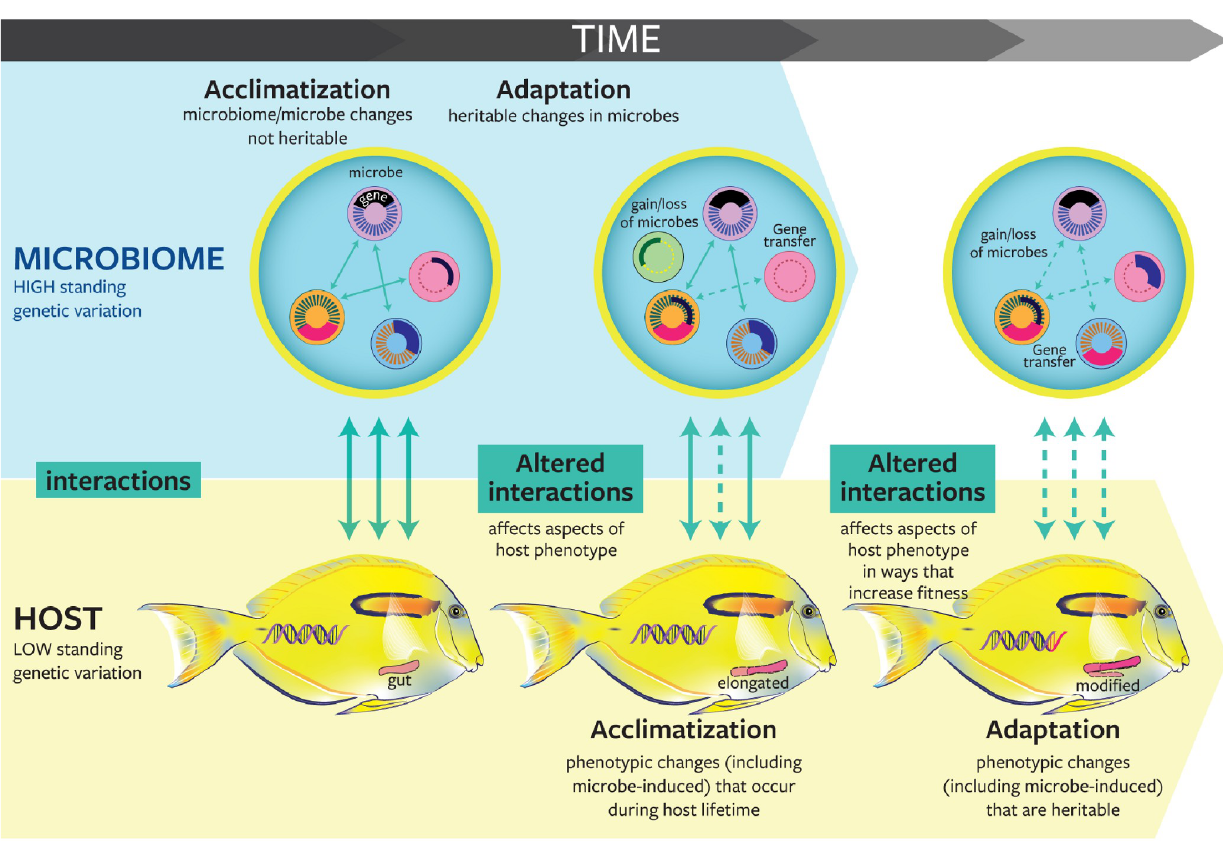
Fig 2. Conceptual representation of the role of microbes in host acclimatization and adaptation. Microbes can frequently adapt to environmental changes more rapidly than their host because of shorter generation times and higher standing genetic variation. Changes that occur at the levels of individual microbes and microbiomes can rapidly generate phenotypic plasticity in a broad range of host traits (i.e., one host genotype expresses multiple phenotypes induced by microbes). Microbially induced phenotypes may promote host adaptation if they become heritable traits. Within microbiomes, transient microbes (thin dashed circles) have limited effects on host phenotype. On the other hand, core microbes (thick dashed circles) that engage in prolonged relationships with hosts and potentially coevolve with hosts likely alter host phenotypes and promote host adaptation. Note that the time scale at which evolutionary changes occur varies widely between organisms, but adaptation is generally slower than acclimatization. Plain line: nonaltered interaction; dashed line: altered interaction; colors of microbes represent different microbial taxa.